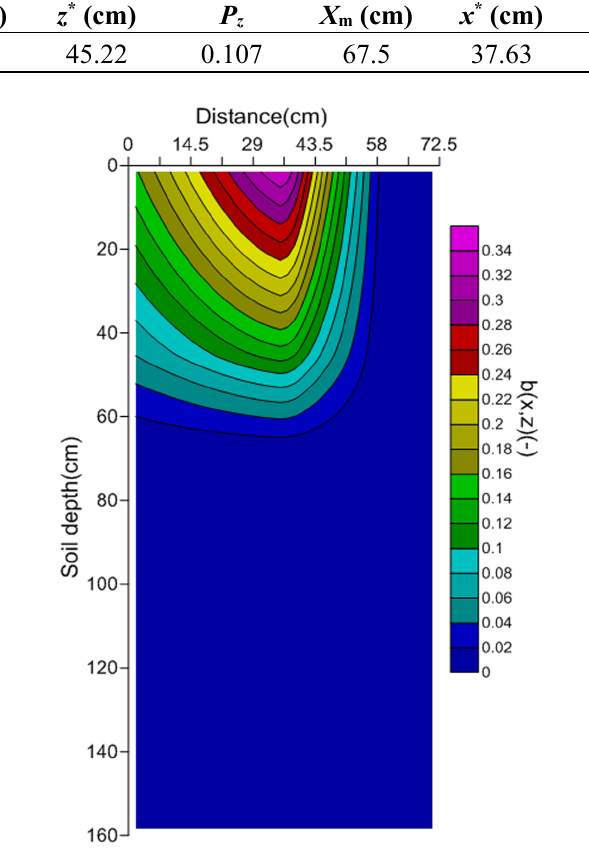
Table 4. Parameters of the root water uptake distribution function.